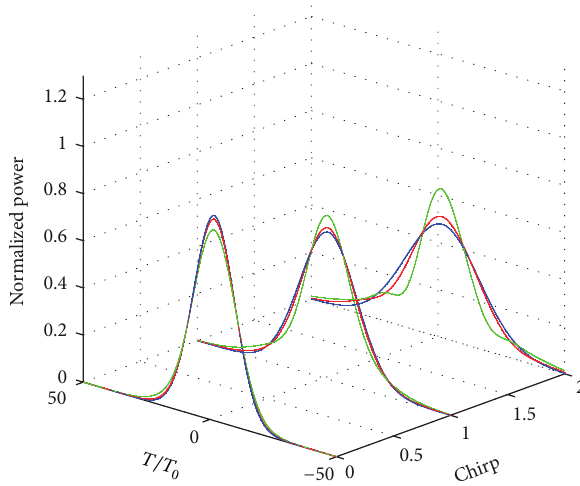
Figure 1: The resulted pulses with Δ𝑡 𝑤 = 0 ps 2 and 𝛽 2 = 0 ps 2 / km for different values of chirp and 𝑘 . Figure 2: The resulted pulses with Δ𝑡 𝑤 = 0 ps 2 and 𝛽 2 = 1 ps 2 / km for different values of chirp and 𝑘 .